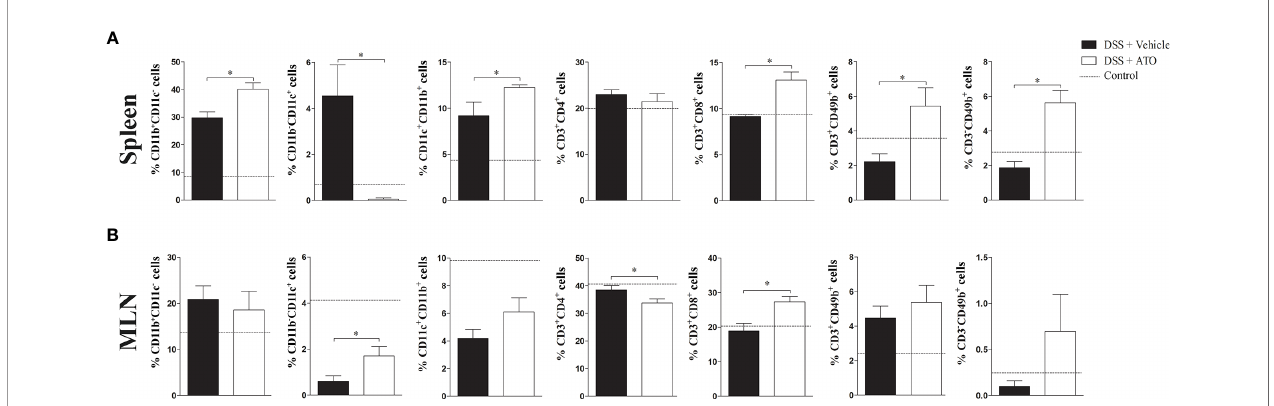
FIGURE 4 | ATO treatment modi fi es the frequency of several immune cell subpopulations in spleen and MLN. C57BL/6 WT mice were exposed to 3% (w/v) DSS in drinking water for 6 days. Mice received oral treatment once daily for three days (days 3-5) with saline (vehicle) or 10 mg/Kg/day ATO. (A, B) The frequency (%) of several immune cell subtypes were assessed by fl ow cytometry in both spleen (A) and MLN (B) . Immune cell subsets were determined by expression of surface markers, including: CD11b, CD11c, CD3, CD4, CD8 and CD49b. The dashed line indicates the values from healthy control mice without colitis induction. These results are representative of 3 independent experiments with 5 mice per group. Unpaired t test or Mann-Whitney non-parametric t tests were used to determine if differences attained signi fi cant response. *p < 0.05. ATO, Atorvastatin; DSS, Dextran sodium sulfate; MLN, Mesenteric lymph